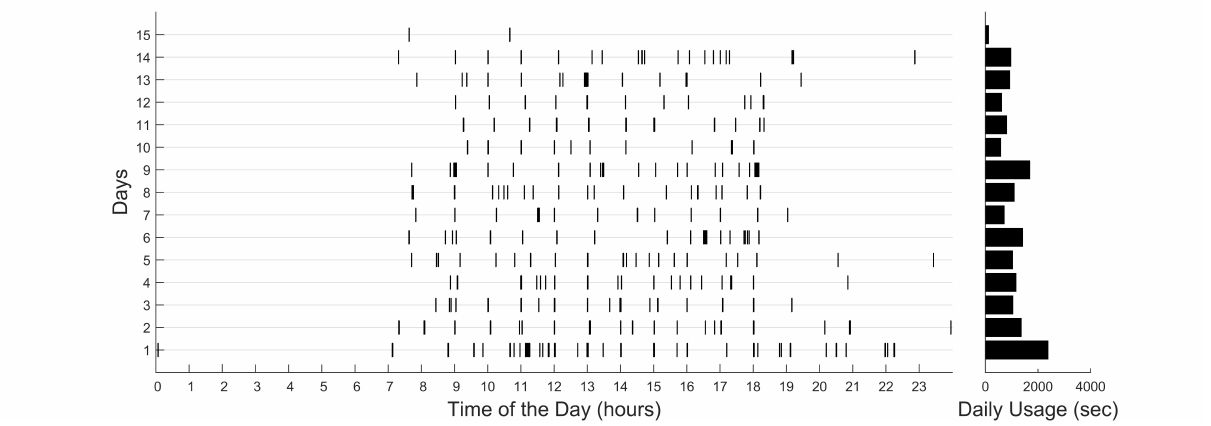
Figure 2. Example phone usage data from a participant. Each row is a day, and the black bars show the extent of time during which the phone has been is use. The bars on the right side show the overall phone usage duration for each